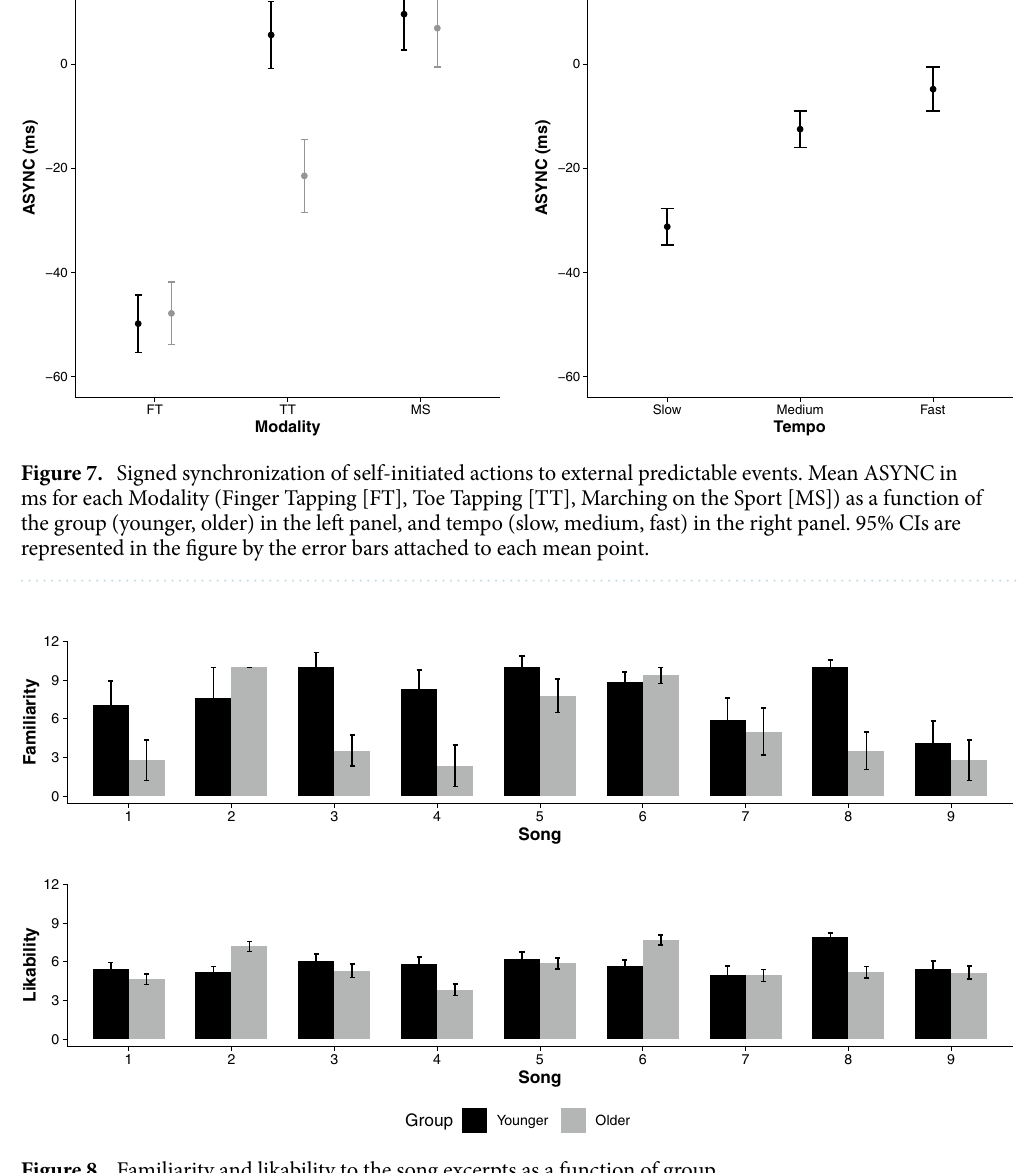
Figure 8. Familiarity and likability to the song excerpts as a function of